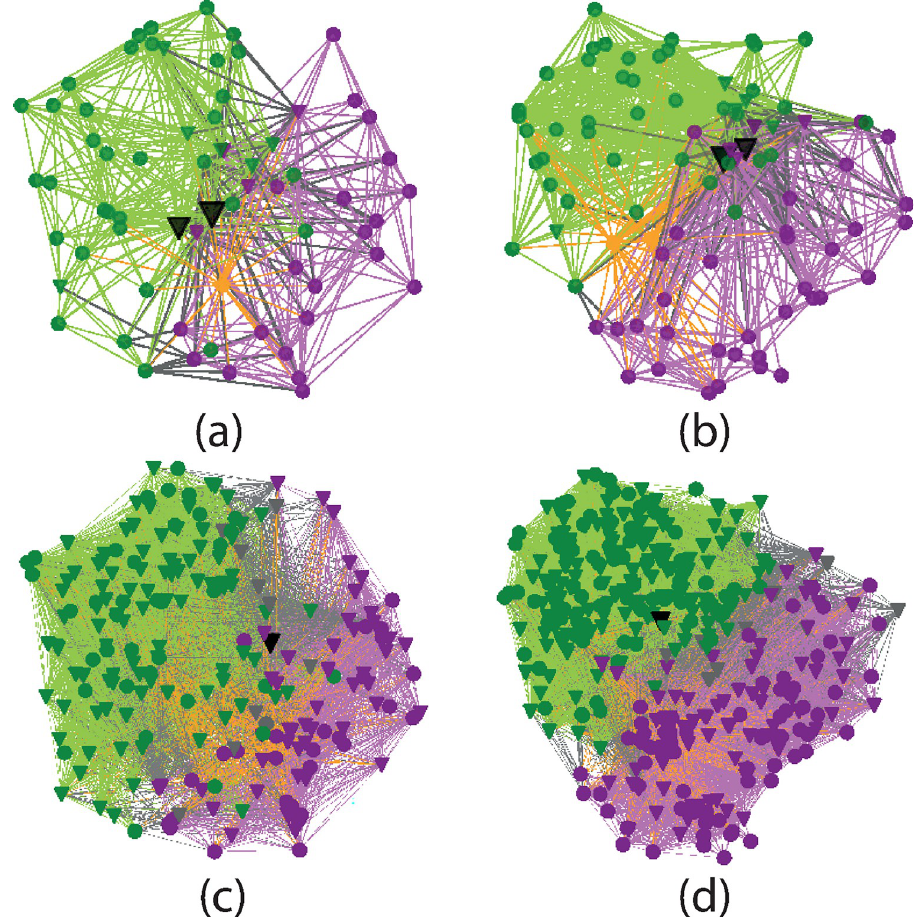
Fig 5. The unipartite projections of the bipartite graphs in Fig 3. (a), (b) are projections of the elements and (c), (d) are projections interactions of respectively T . thermophilus and S . cerevisiae . The filled triangles indicate elements and interactions involving rRNAs and the filled circles are all others. The nodes with the largest degrees are indicated in black.